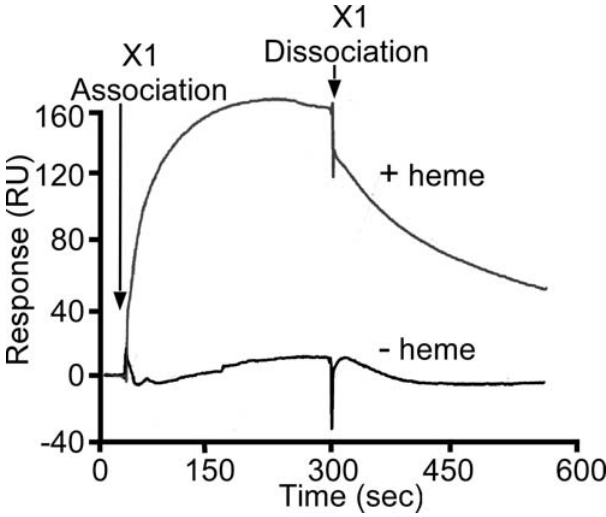
Figure 6. Association and dissociation of IsdX1 and hemoglo- bin. Interactions between IsdX1 with hemoglobin (with bound heme) or apo-hemoglobin (lacking heme) were assessed by surface plasmon resonance